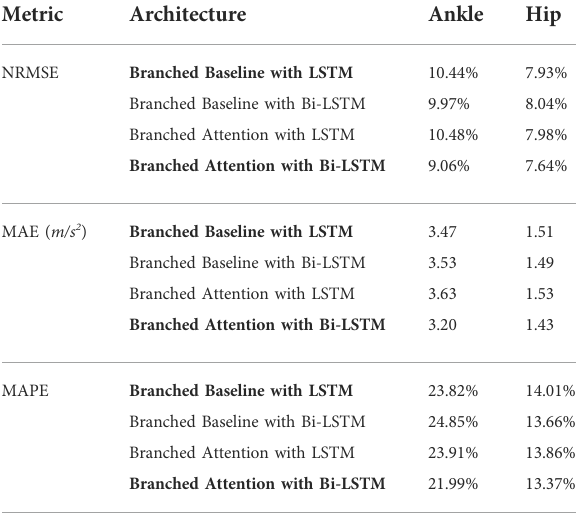
The selected models are bold .